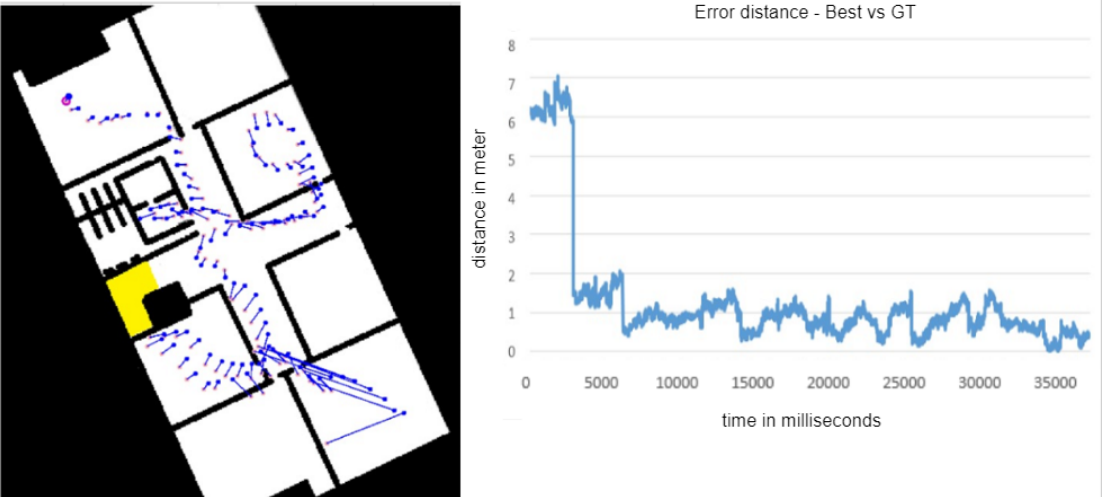
Figure 11. ( Left ): The pink dots are the STEPS reported locations, and the blue dots are the ground truth. ( Right ): The graph shows the error distance between them, as well as the length of the lines between each coupling of a ground truth point and its related STEPS